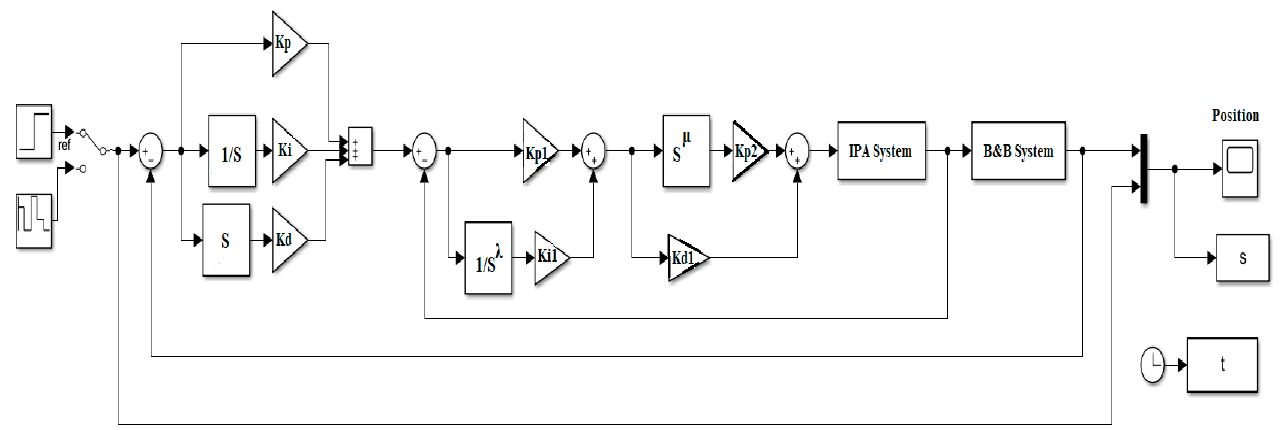
Figure 15. Simulink diagram for simulation IPABB system.